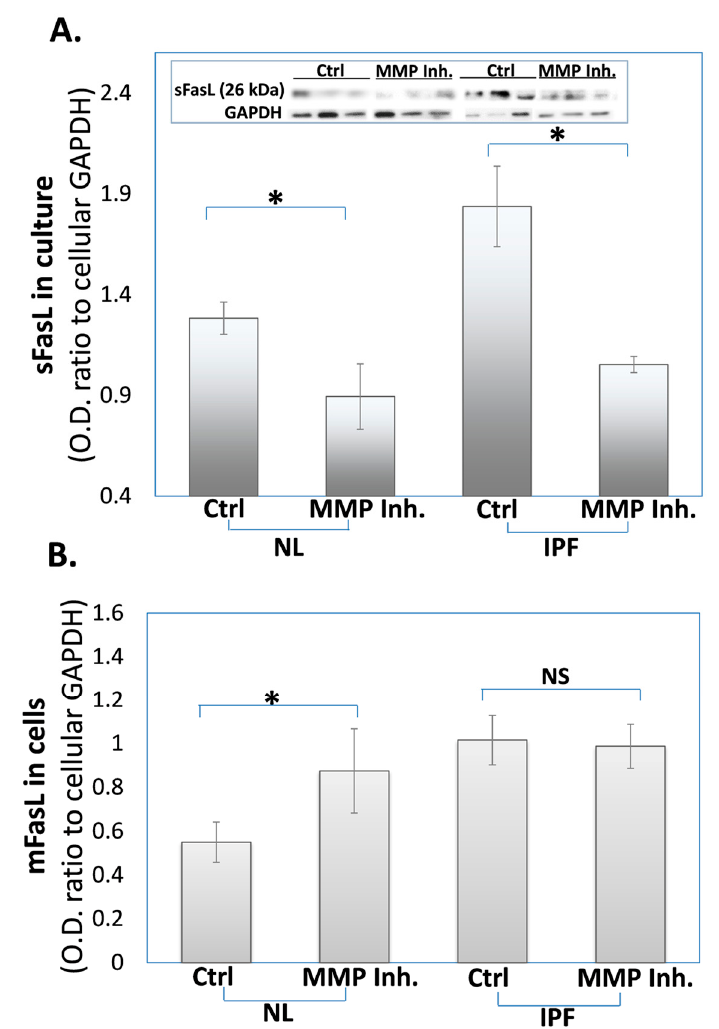
Figure 1. The decreased soluble and increased membrane FasL levels in fibrotic-(IPF) and normal (NL)-lung myofibroblasts, following exposure to the batimastat MMP inhibitor. Western blot of: ( A ) sFasL in culture medium and ( B ) mFasL, of fibroblast cell lines (3 × 10 5 ) of fibrotic-lung/ATCC191 (IPF)- or normal/ATCC151 (NL)-lungs; Graphical presentation and blots (insert) with optical density ratios normalized to fibroblasts GAPDH after treatment with control-vehicle (0.1% DMSO) or batimastat (24 h, 10 µM). Mean ± standard deviation; n = 4; * p < 0.05, NS— p > 0.05.